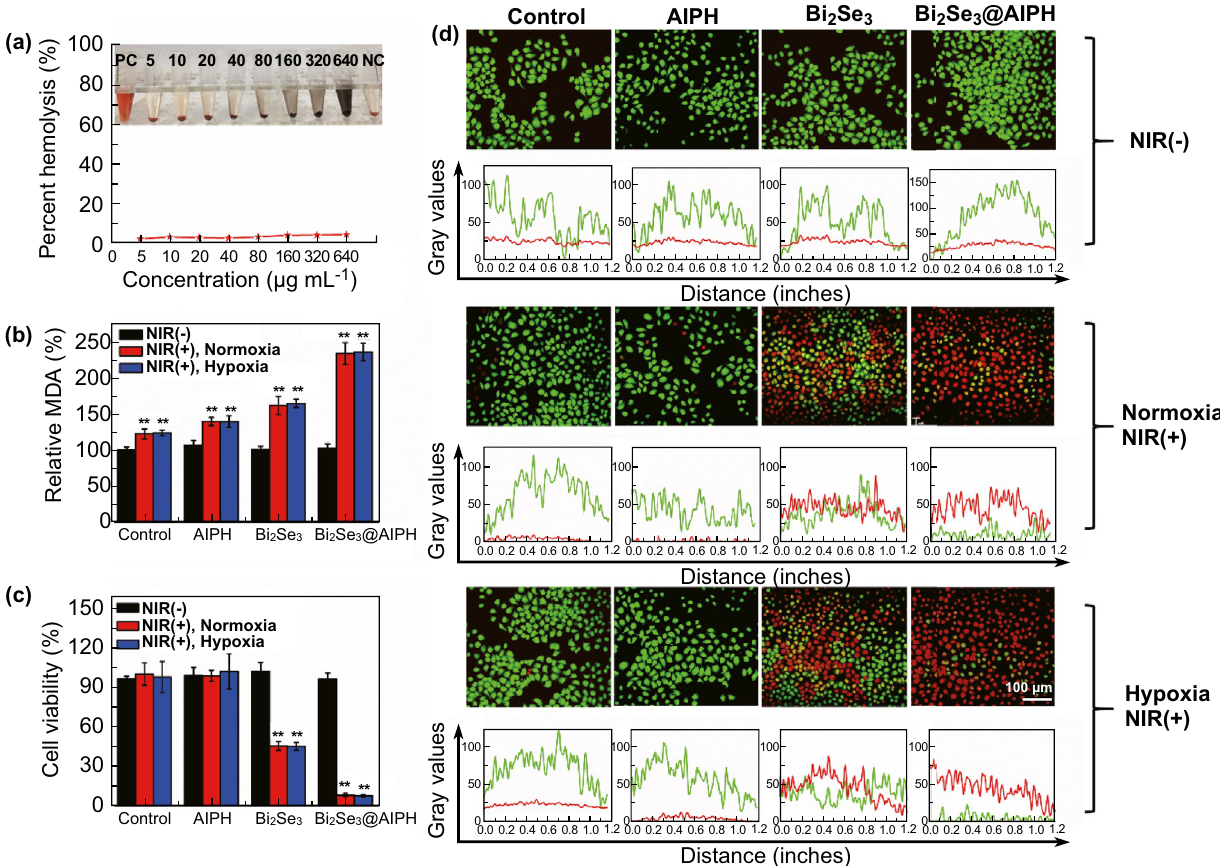
Fig. 3 Evaluation of biocompatibility and cytotoxicity. a Hemolytic percentages of red blood cells incubated with Bi 2 Se 3 @AIPH NPs at the concentrations of 5, 10, 20, 40, 80, 160, 320, and 640 µg mL −1 for 2 h. Inset: hemolysis photograph after centrifugation. b Relative MDA percentage after treatment with PBS, AIPH, Bi 2 Se 3 , and Bi 2 Se 3 @AIPH. c Cytotoxicity to HepG2 cells treated with PBS, AIPH, Bi 2 Se 3 , and Bi 2 Se 3 @AIPH in normoxic and hypoxic atmosphere. d Apoptosis images and gray value analysis of HepG2 cells treated with PBS, AIPH,